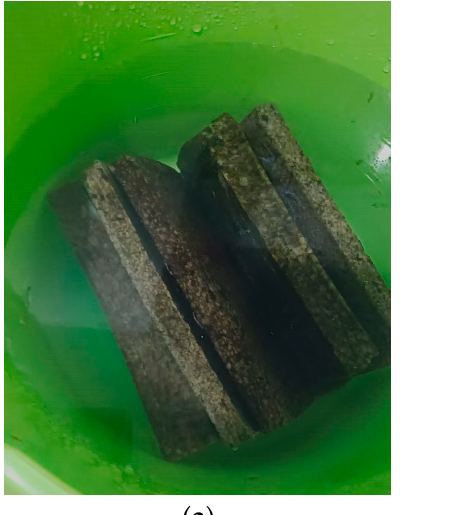
Figure 8. Performing the water absorption test. ( a ) Bricks immersed in water. ( b ) Weight check after 24 h.